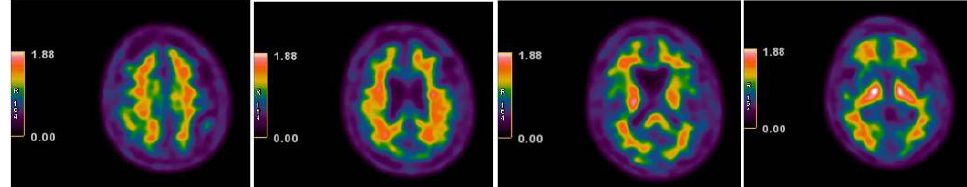
Figure 4. Amyloid-negative PET scan with 18F-flutemetamol five years after symptom onset: SUM PET representative axial slices on the spectrum color scale (normal tracer distribution).